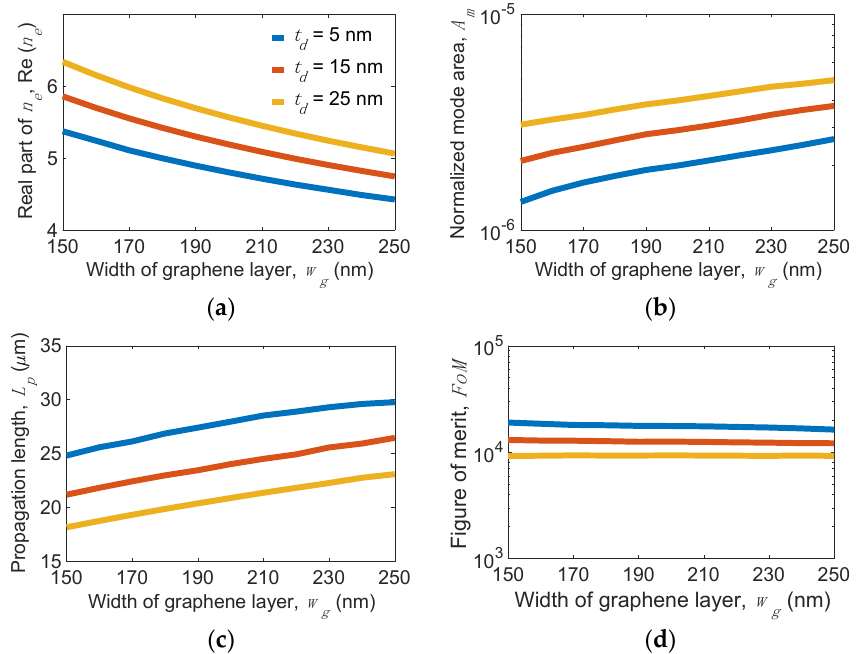
Figure 9. ( a ) Real part of effective index n e , Re( n e ), ( b ) normalized mode area, A m , ( c ) propagation length, L p , and ( d ) figure of merit, FoM, of the present structure versus w g for different t d values at w r = 10 nm, h r = 30 nm , and t Si = 5 nm.